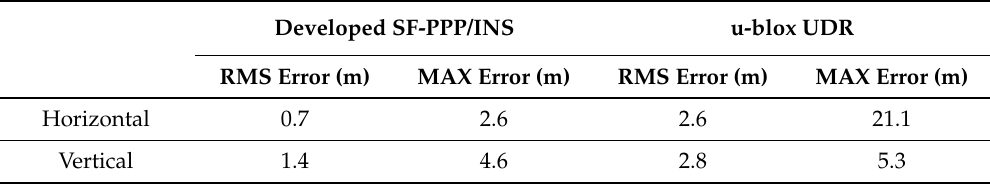
Table 3. The RMS and maximum position errors, before entering the underground parking in the second trajectory. The developed SF-PPP/INS system maintained sub-meter horizontal accuracy and meter-level vertical accuracy, and was better than UDR solution.